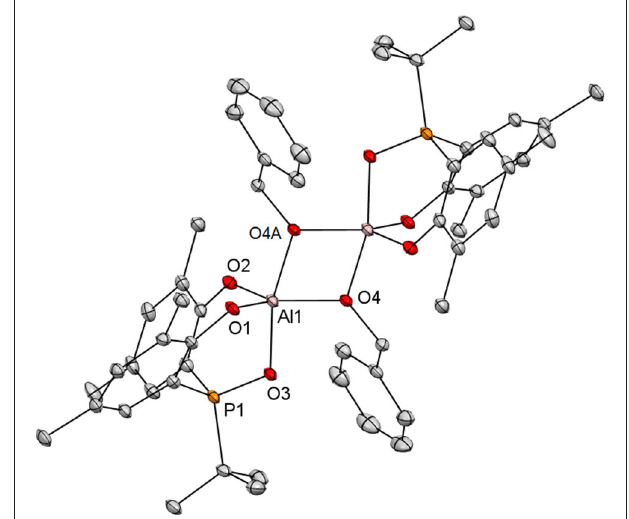
ellipsoids drawn at the 35% probability level. All hydrogen atoms and the methyl groups in arylated tert -butyls are omitted for clarity. Selected bond distances (Å) and angles (deg): Al(1)-O(2) 1.7766(18), Al(1)-O(1)